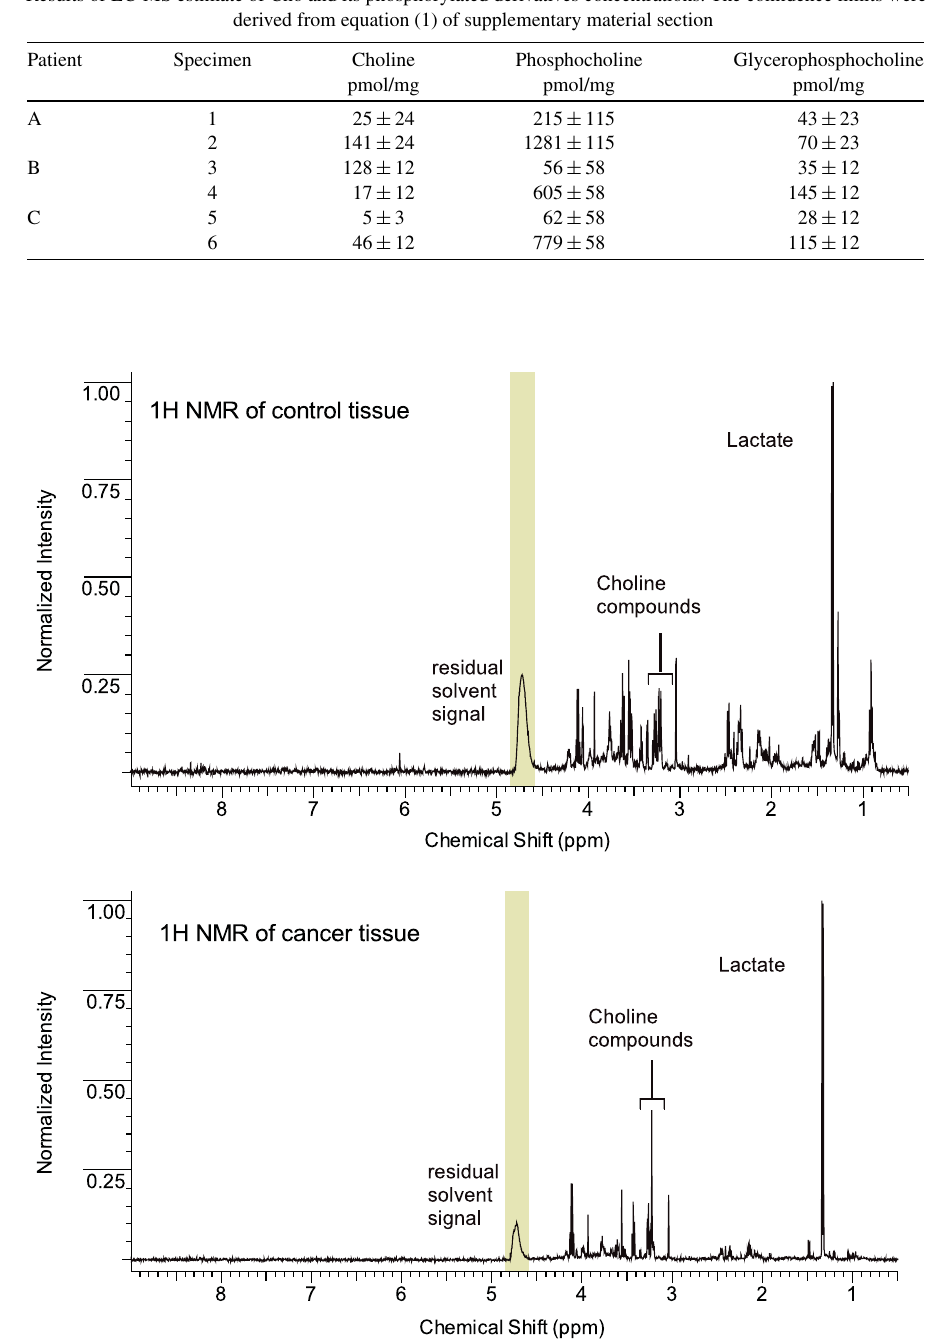
Fig. 5. Examples of 500 MHz 1 H NMR spectra obtained from biopsy aqueous extracts. The top panel refers to healthy breast tissue (sample A-1) and the bottom panel refers to cancerous breast tissue (sample A-2). The region of the N -trimethyl groups of choline compounds and the peak of lactate (the most intense resonance in both spectra) are indicated. The residual solvent signal is